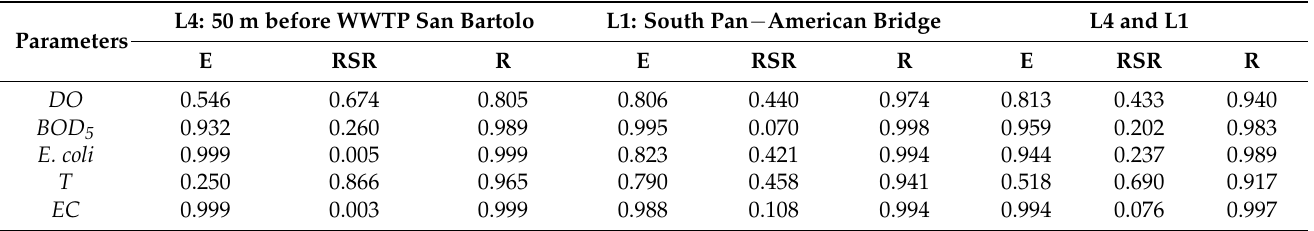
Table 3. Efficiency indices E and RSR, and Pearson’s correlation (R) in the calibration of the Iber model for T , EC , DO , BOD 5, and E. coli .